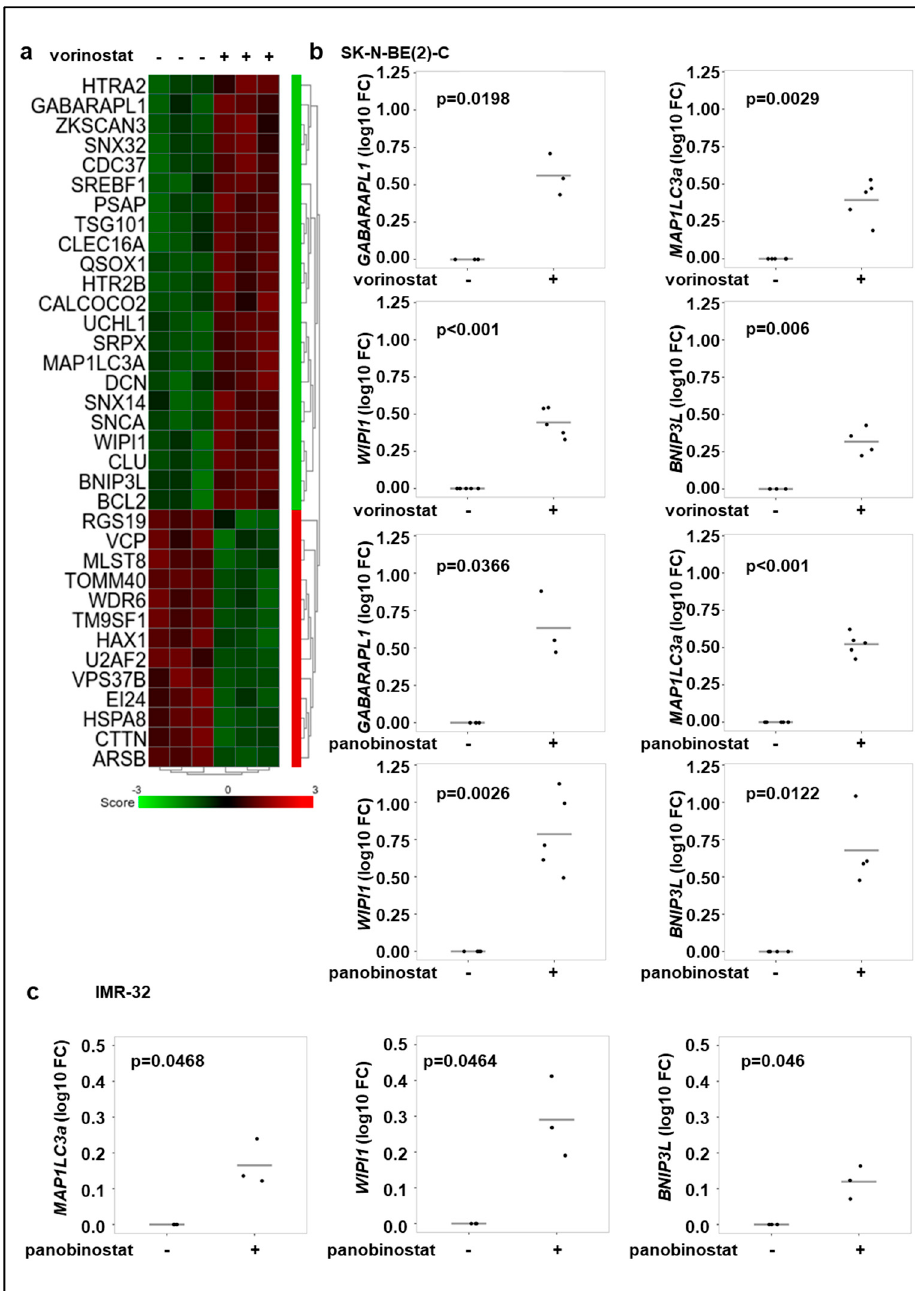
Figure 2. Broad-spectrum HDAC inhibitor treatment increases the expression of autophagy genes. ( a ) Gene expression analysis of genes with the ontology term “autophagy” of SK-N-BE(2)-C neuroblastoma cells. Cells were treated for 24 h with vorinostat (500 nM) in three replicates. Genes, which are significantly up- or downregulated ( p < 0.05) are shown. ( b ) Realtime RT-PCR analysis of GABARAPL1 , MAP1LC3a , WIPI1 , BNIP3L after 24 h treatment of SK-N-BE(2)-C cells with vorinostat (500 nM) or panobinostat (10 nM). ( c ) Realtime Quantitative RT-PCR analysis of MAP1LC3a , WIPI1 , BNIP3L after 24 h treatment of IMR-32 cells with panobinostat (4 nM). Statistical analyses were performed using one sample t -test. Boxes represent the